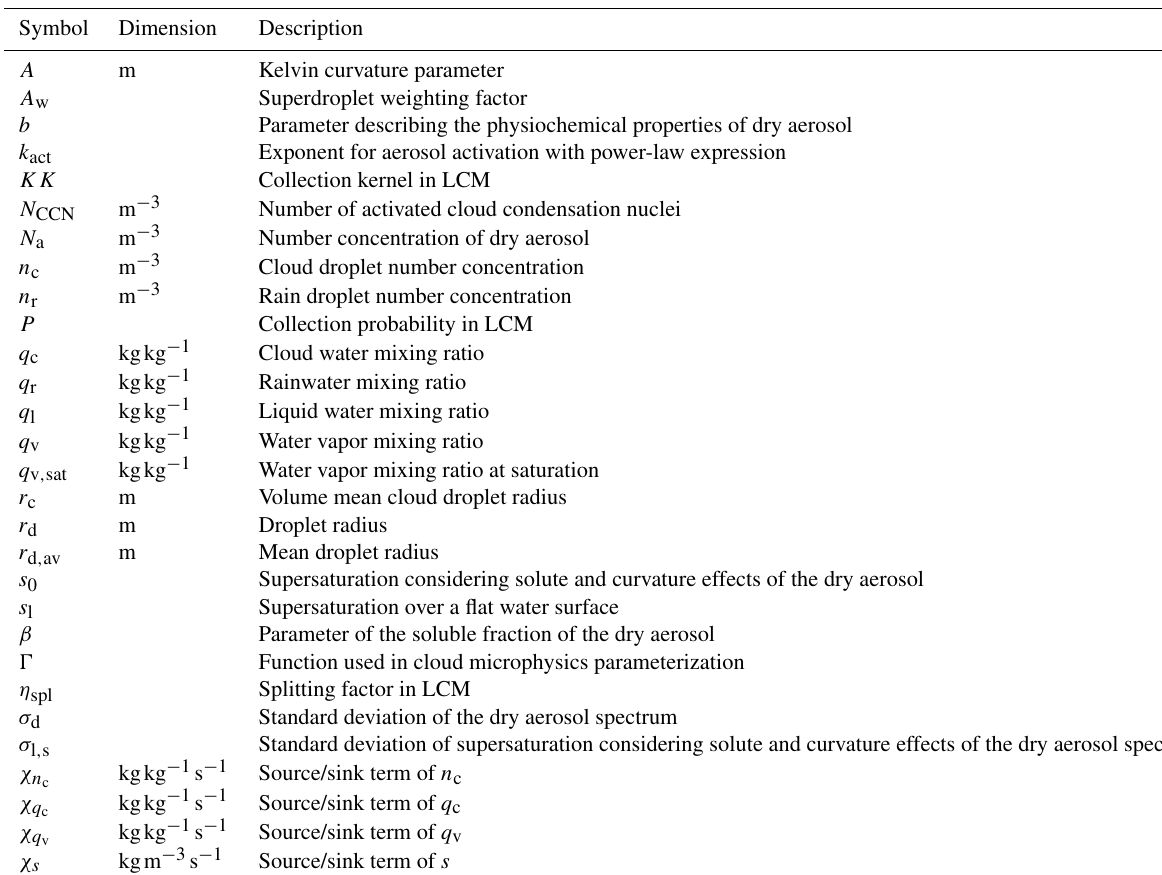
Table 5. List of symbols related to clouds and